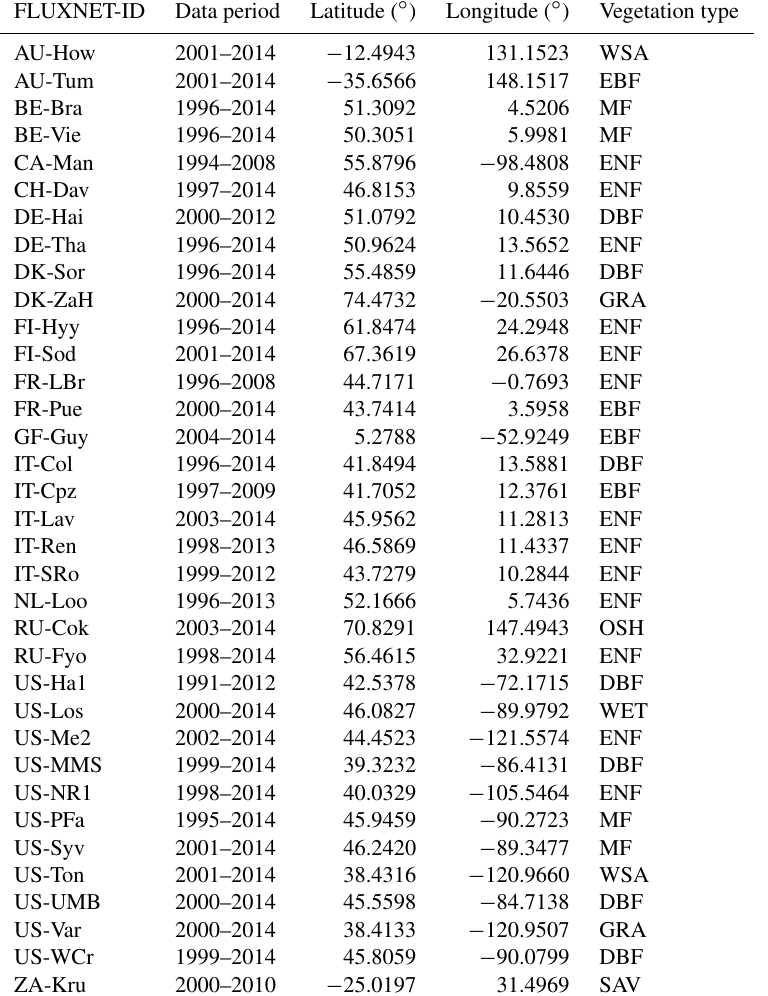
Table 2. Eddy covariance sites used for comparison. For vegetation type abbreviations, see Fig. 3